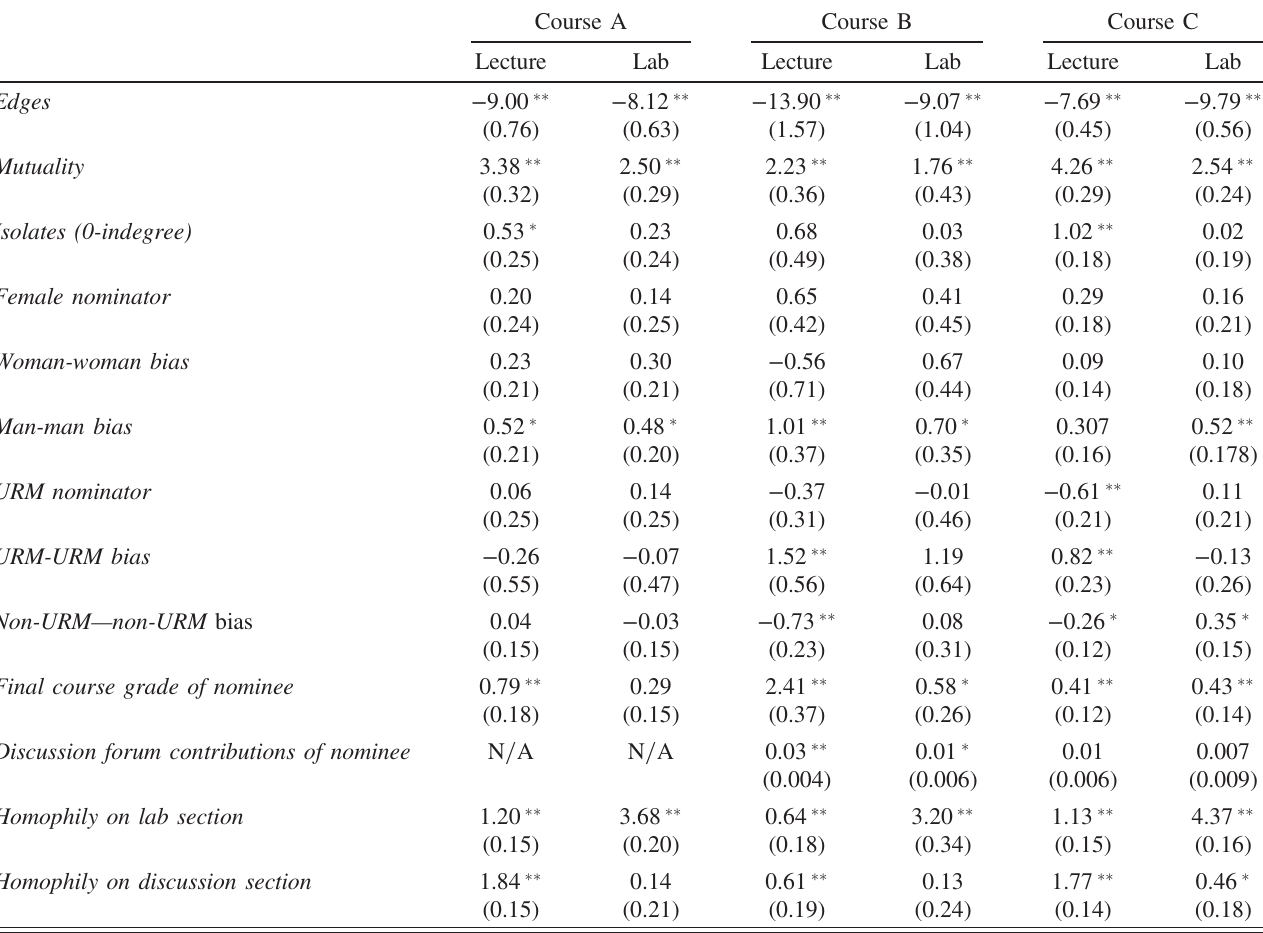
TABLE V. ERGM coefficient estimates using the original model of Grunspan and colleagues [30]. Standard errors of the coefficient estimates are in parentheses. Asterisks indicate statistical significance ( (cid:3) p < 0 . 05 ; (cid:3)(cid:3) p < 0 . 01 ). For every network, the goodness-of-fit diagnostics for the revised model are better than those for the original model (shown in Fig.